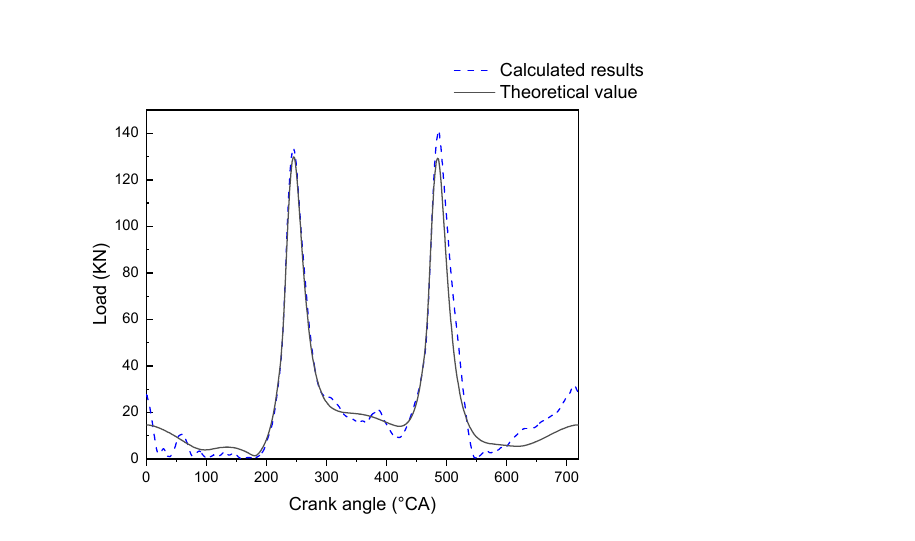
Figure 10. Theoretical and simulation comparison curves.